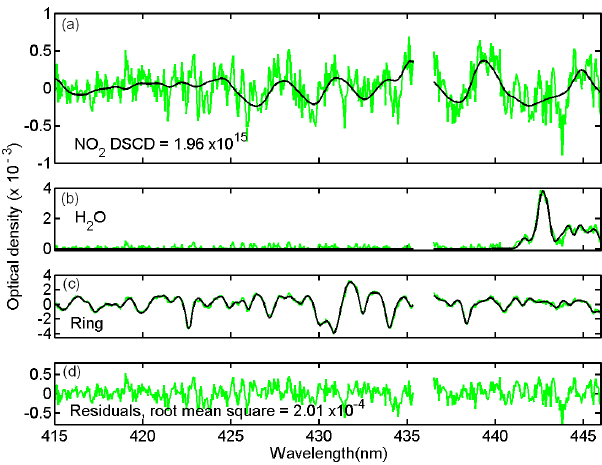
Fig. 3. Example of a DOAS fit of a spectrum recorded on 8 April 2008, when the plane was in the marine boundary layer. Black lines correspond to molecular and Ring cross-sections scaled to the detected absorptions in the measured spectrum (green lines). Note that the pixels between 435.4 and 436.5 nm are damaged.